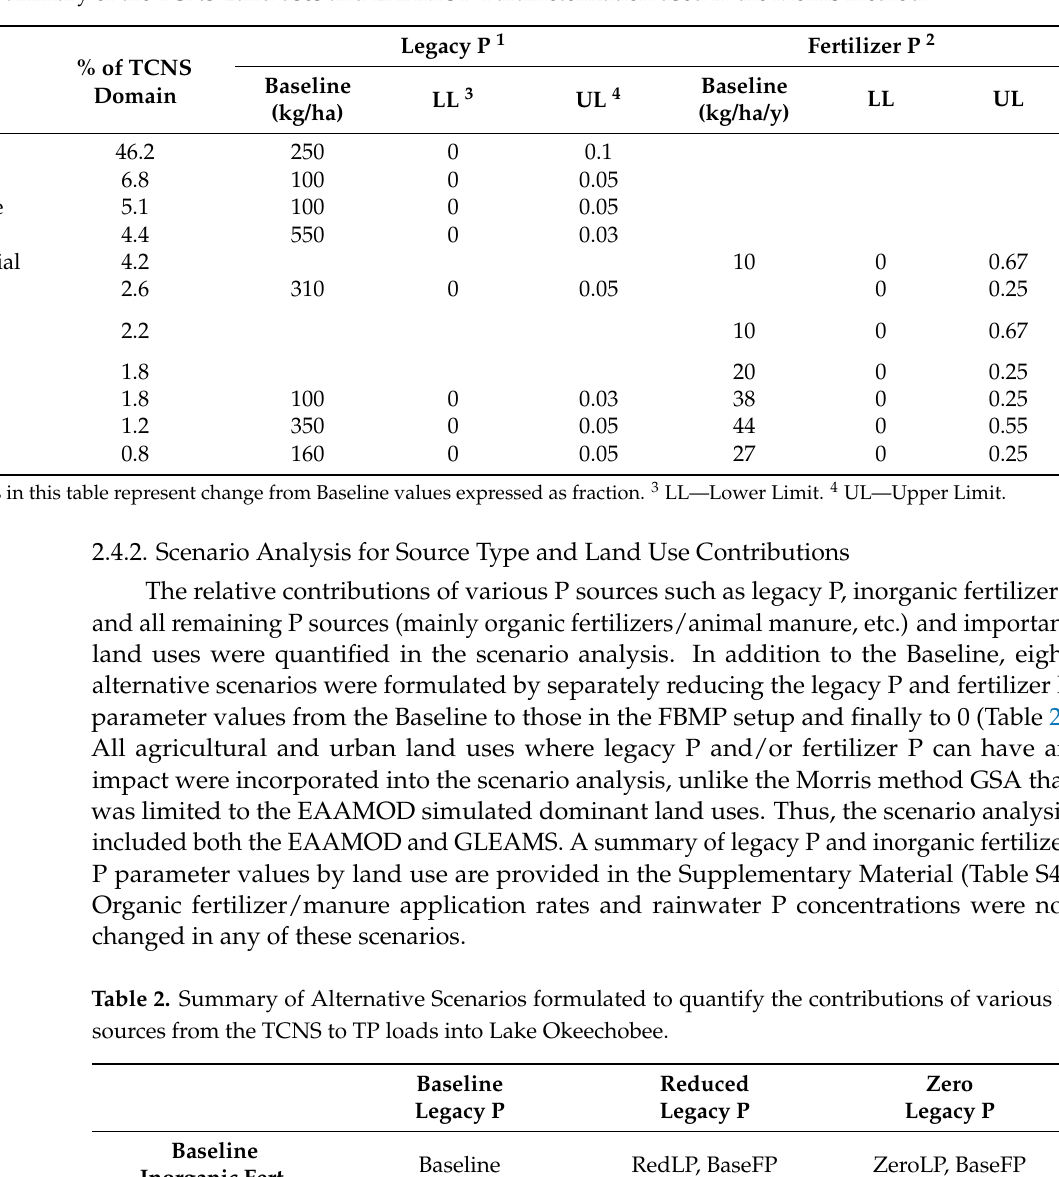
Baseline Reduced Legacy P Legacy